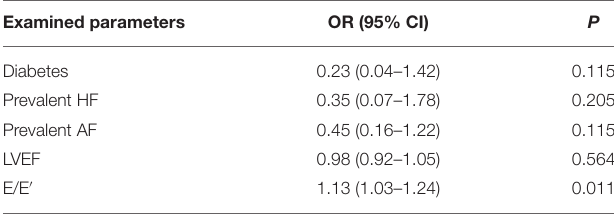
TABLE 3 | Multivariate analysis of predictors of recovered ejection fractions.